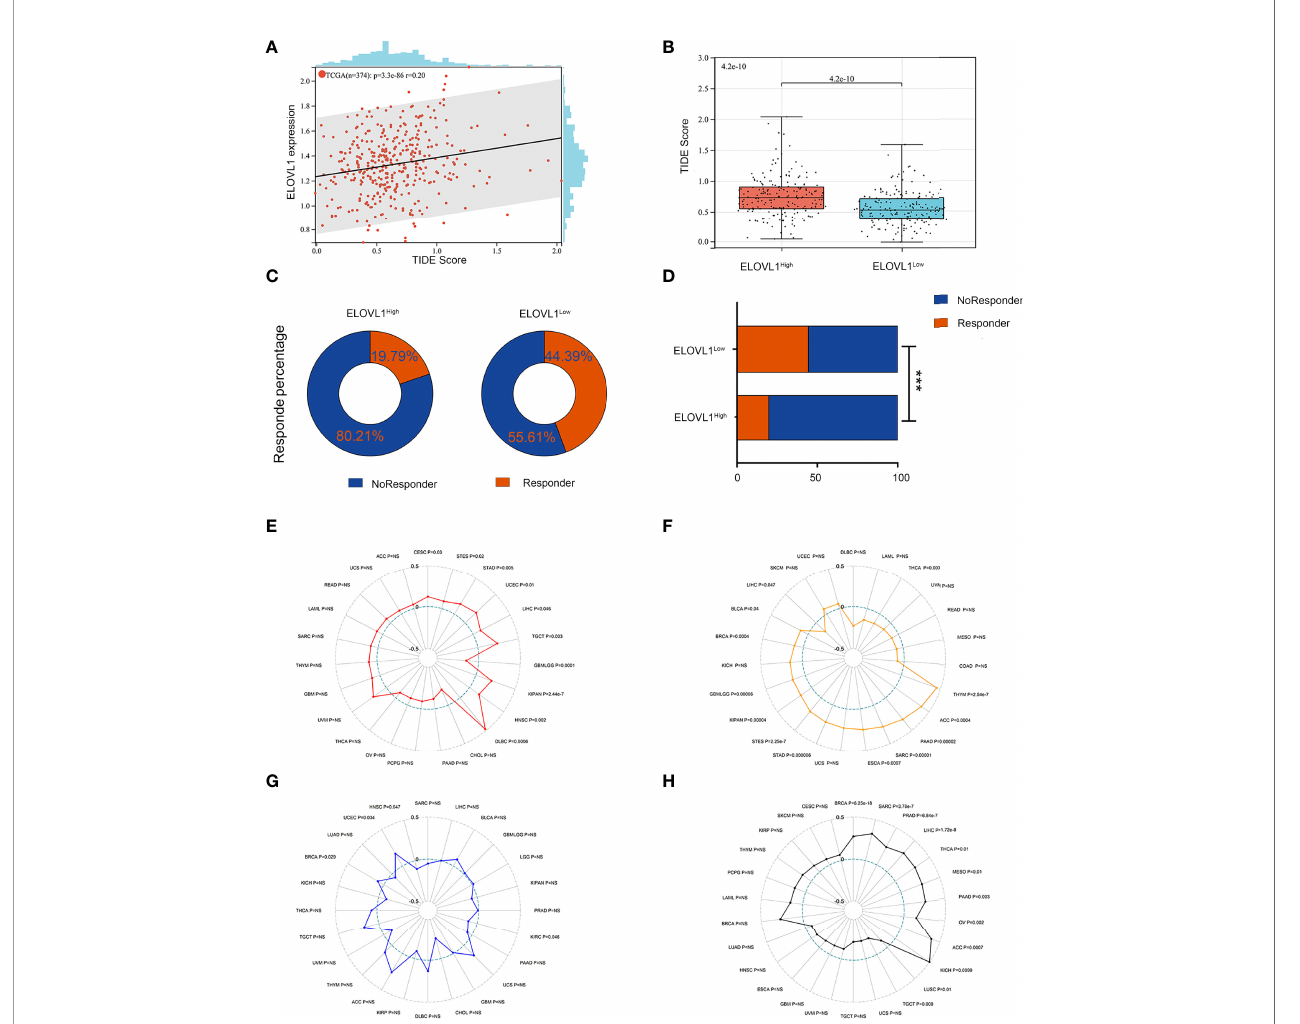
FIGURE 8 | Relationship between ELOVL1 and response to immunotherapy. (A) The associations between ELOVL1 expression and TIDE score. (B) High ELOVL1 was positively correlated with high TIDE score. (C, D) High ELOVL1 group had a higher proportion of tumor immune dysfunction and rejection. (E) Relationship between ELOVL1 and MSI. (F) Relationship between ELOVL1 and TMB. (G) Relationship between ELOVL1 and neoantigen. (H) Relationship between ELOVL1 and HRD. ***P <